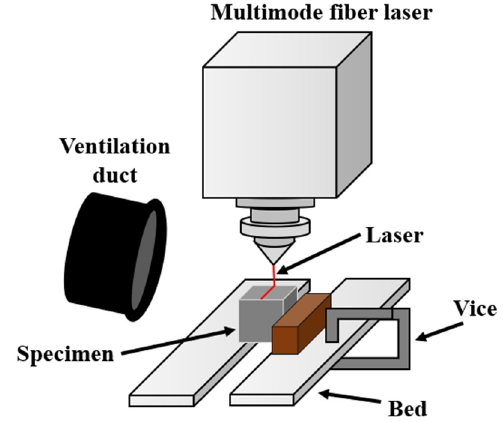
Figure 1. Scheme of fiber laser cutting machine [52].